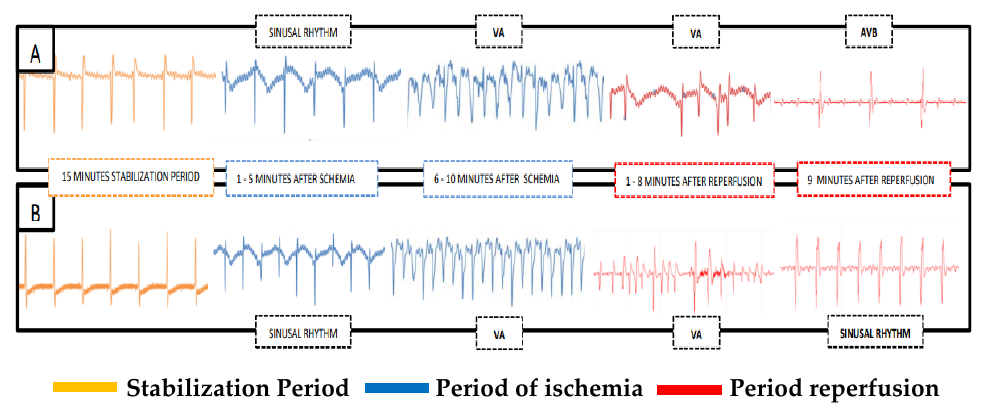
Figure 1. ( A ) ECG recording of animals submitted to the CIR without treatment with ENOX; ( B ) ECG recording of animals submitted to the CIR under treatment with ENOX, intravenously, immediately before performing cardiac ischemia due to occlusion of the left descending coronary artery. AV = Ventricular arrhythmia; AVB = Atrioventricular block; CIR = Cardiac ischemia and reperfusion.